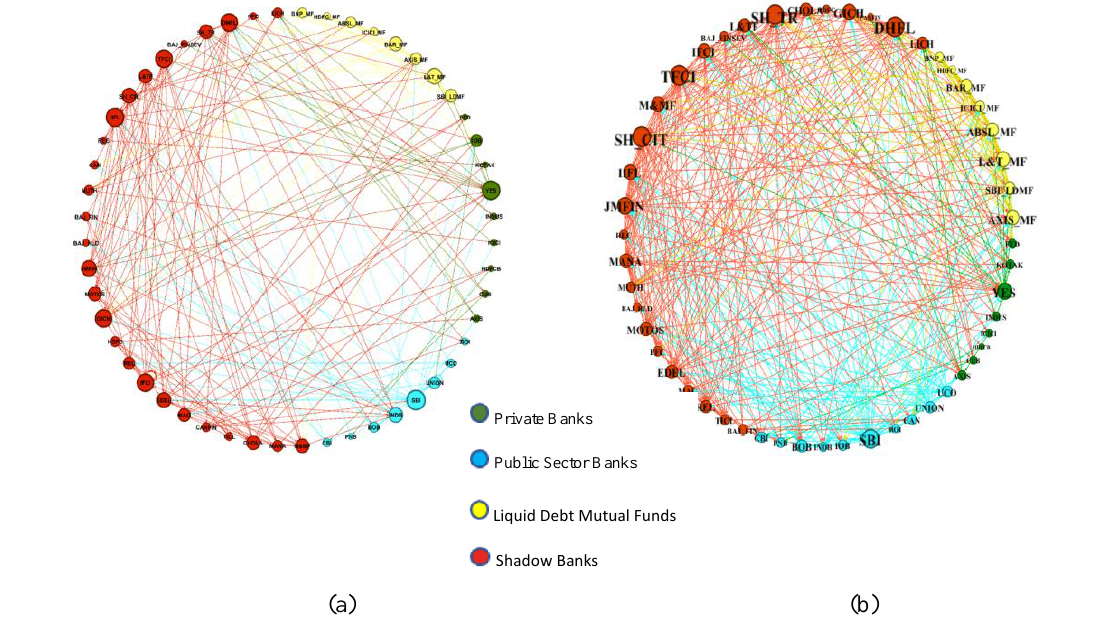
Figure 1. Complex Granger-causality NBFC network comparison for (a) the pre-crisis period (b) the crisis period. The edges have color same as the source